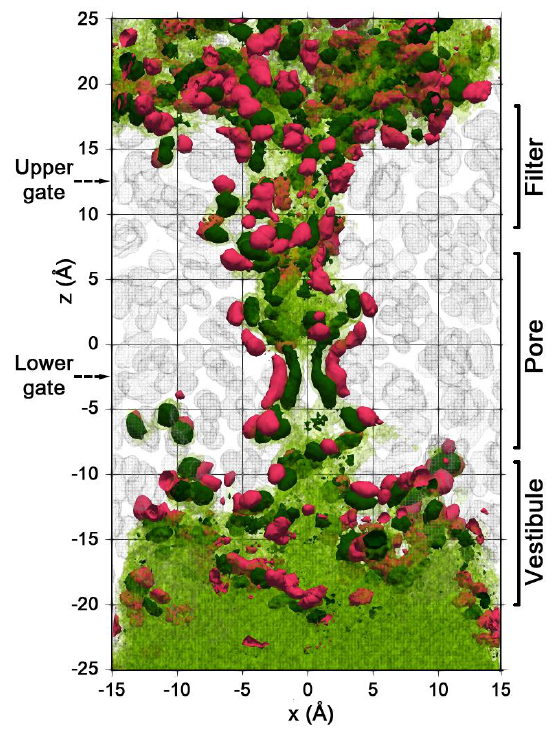
Figure 4. Spatial density distribution of protein atoms, water molecules, and protein–water hb in the cylinder (ø30 × 50 Å) along the pore axis averaged over one of the trajectories. Gray—isosurface of protein density ρ = 0.1 atom/Å 3 (part of the protein is removed for clarity), dark green—water with ρ = 0.1 mol/Å 3 , green semi-transparent—water with density similar to the bulk water ρ = 0.03 mol/Å 3 , pink—water-protein hb with ρ = 0.1 bound/Å 3 . Boundaries of the vestibule, pore, and filter domains are shown on the right. Dashed arrows mark the levels of the upper and the lower gates.